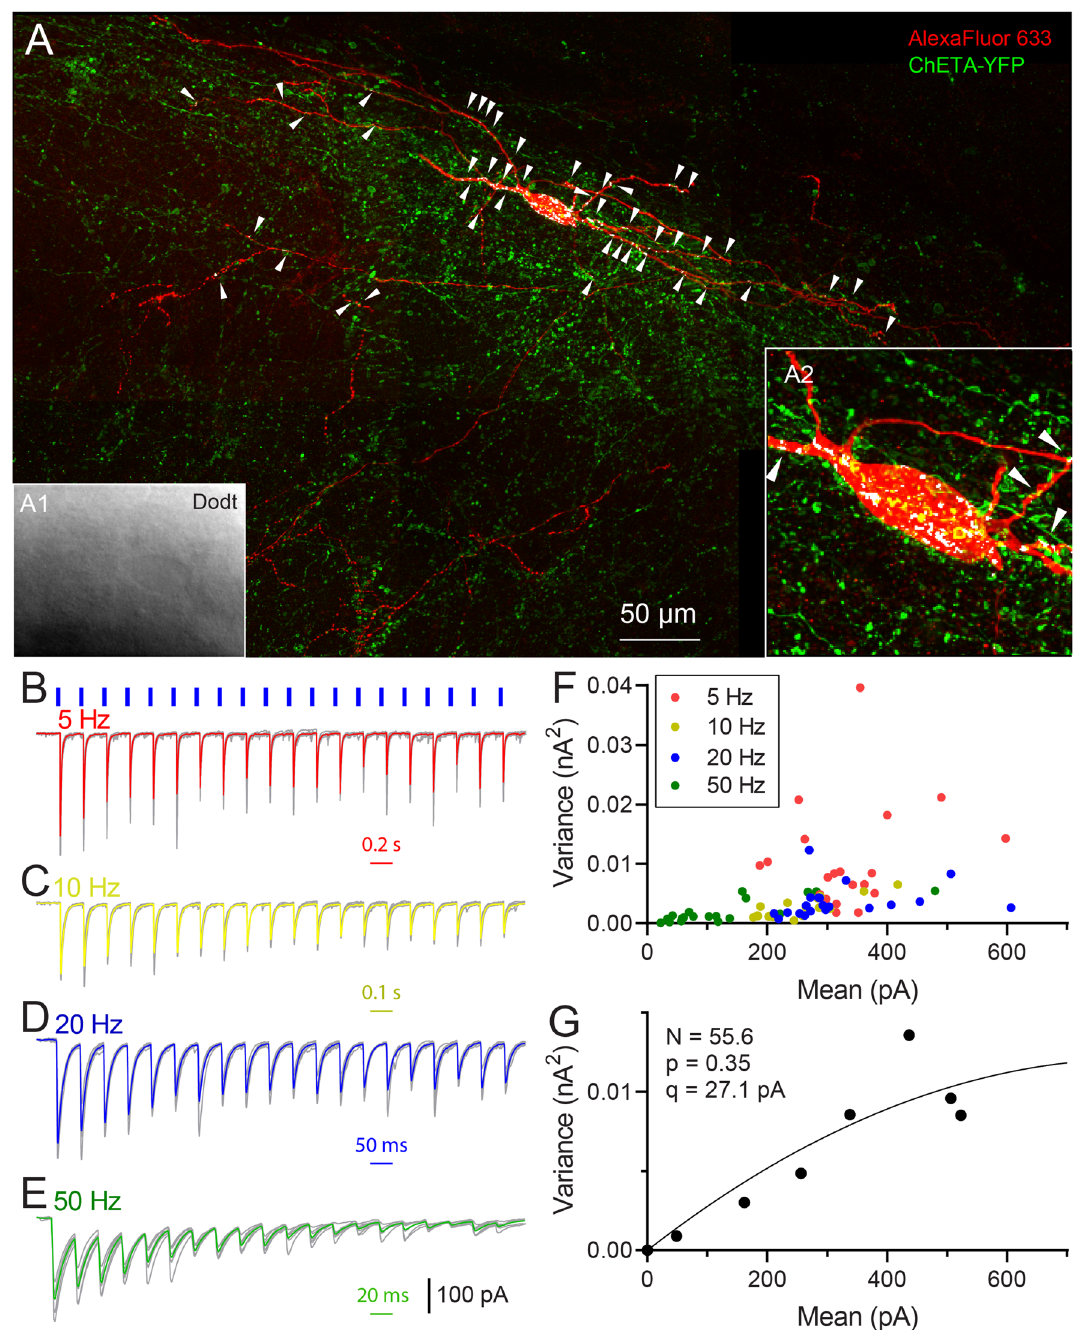
Figure 4. A second example of PV MS-DBB transmission onto a hippocampal CA1 stratum oriens interneuron. ( A – G ) are formatted similarly to Fig. 3. ( A ) A larger number of potential actual contacts were observed, which correlated with ( G ) a larger number of release sites extracted from VM